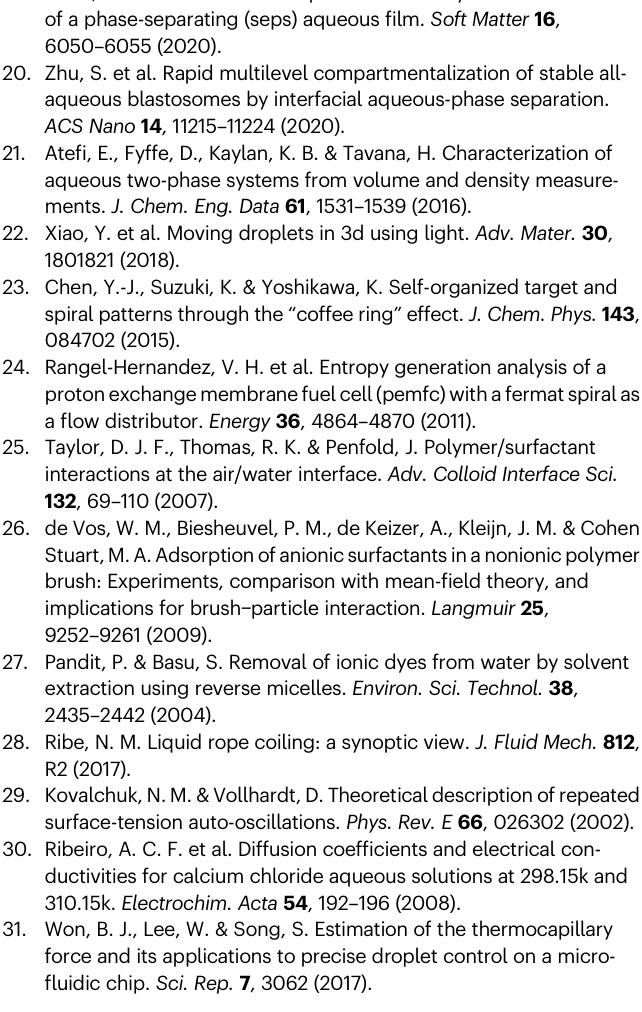
FT-IR . The white solid: FT-IR ν /cm – 1 2957, 2924, 2854, 1651, 1602, 1465, 1186, 1131, 1048, 1012, 830, 673, 606, and 581. The FT-IR spectrum of the white solid (Supplementary Fig. 13, black line) coalescences well with that of SDBS (Supplementary Fig. 13, red line), with almost no peaks for PEG observed (Supplementary Fig. 13, blue line), further con fi rming that Ca(DBS) 2 is the main component in the